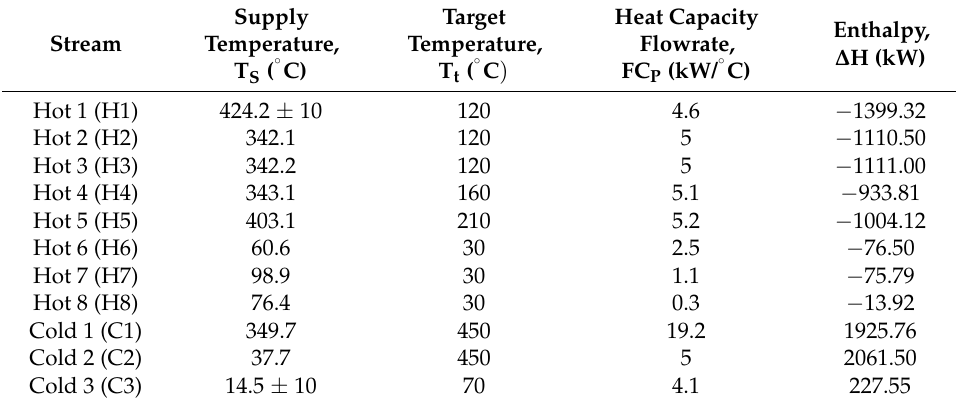
Table 4. Stream data of Case Study 1 [29].